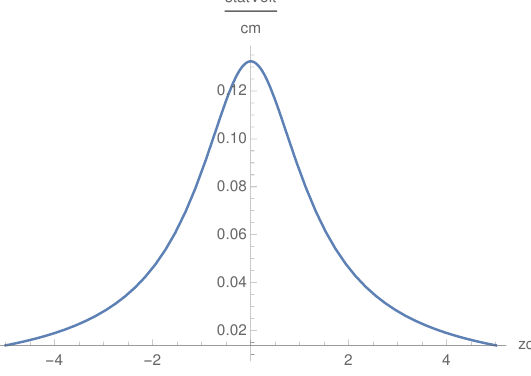
Figure 5. E y as a function of z for x = 1.2 cm, ω = 1.5